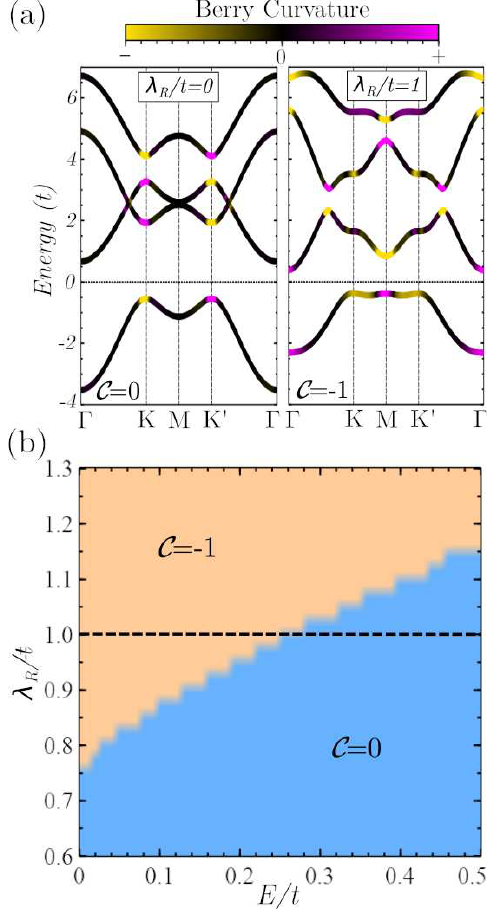
Figure 4: Topological analysis of the interacting Hamiltonian at U / t = 6 and V / t = 1.5. (a) Effect of the Rashba spin orbit coupling ( λ ture, Berry curvature and Chern number C : for λ λ = 1.0, C = − 1 (right panel). (c) Phase diagram of the Chern number as a function R / t and the external electric field bias E / t . At a given value of λ of λ R λ = 1.0, dashed line) it is possible to modify the topological character of the system R with an electric